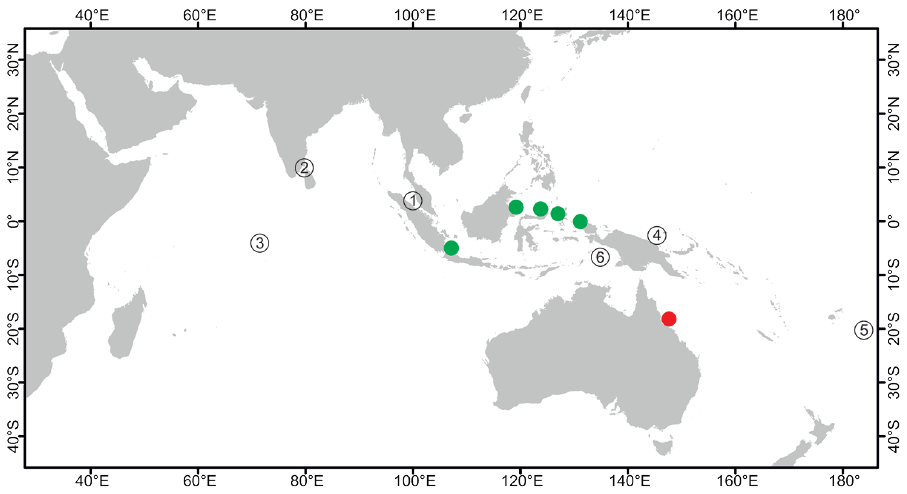
Figure 11. Distribution of Cinachyrella porosa . Red dot: type locality, Spiretta porosa Lendenfeld, 1888, Port Denison, Queensland, Australia. Green dots: Indonesian localities where the species was collected recently. Circled numbers: type localities of synonymized species 1 Cinachyra malaccensis Sollas, 1902, Malacca Strait, Malaysia 2 Tetilla anomala Dendy, 1905, Chilaw, Sri Lanka 3 Cinachyra albatridens Lend- enfeld, 1907, Diego Garcia, Chagos Archipelago 4 Cinachyra albaobtusa Lendenfeld, 1907, Anachoreten (=Keniet) Islands, Papua New Guinea 5 Cinachyra albabidens Lendenfeld, 1907, Tonga Islands 6 Tethya clavigera Hentschel, 1912, Aru Island,